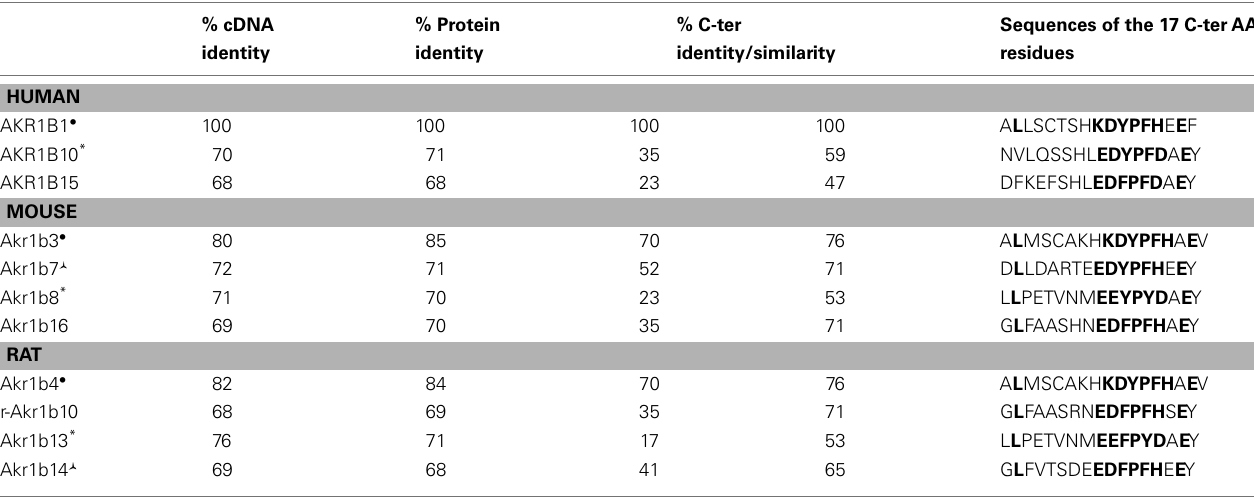
Table 1 | Comparison of protein sequence ofAKR1B.